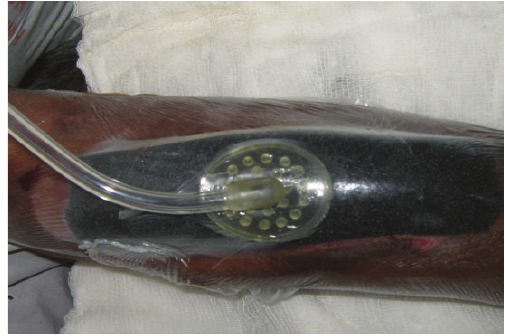
Figure 3: The connecting tube was applied after making a small opening (3-4mm) on the drape.